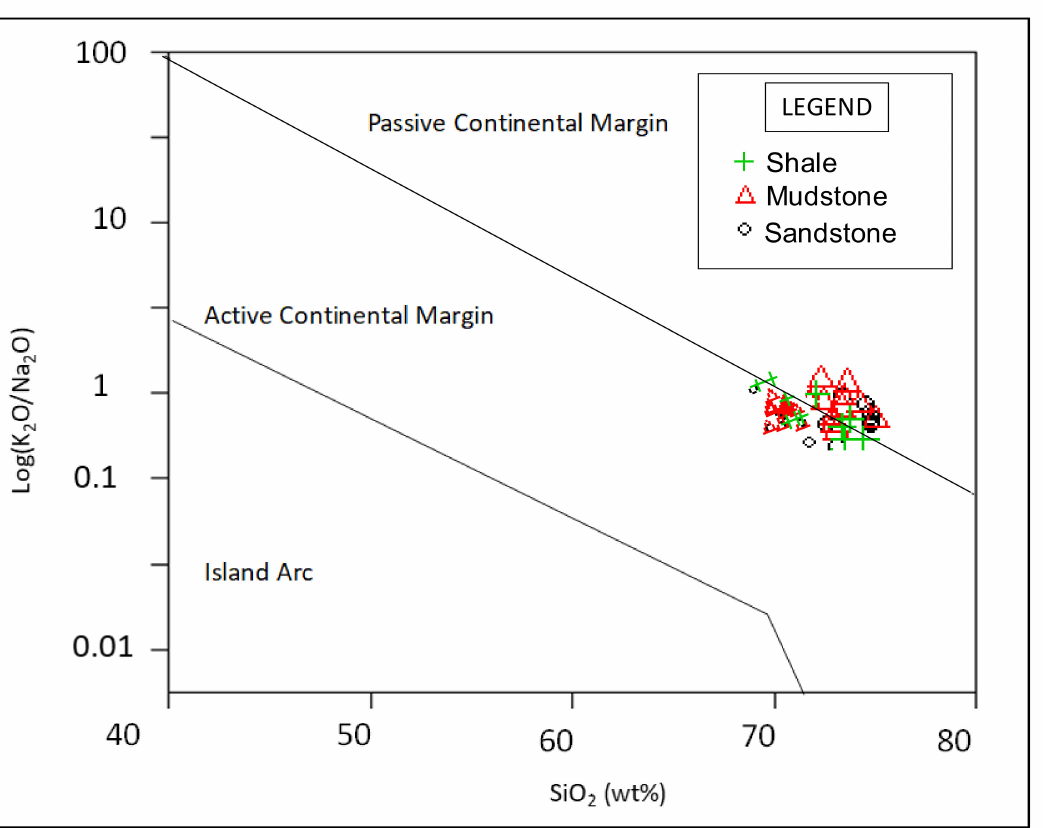
Figure 9. Bivariate plot of SiO 2 versus K 2 O/Na 2 O for the studied samples showing tectonic setting (Background field after